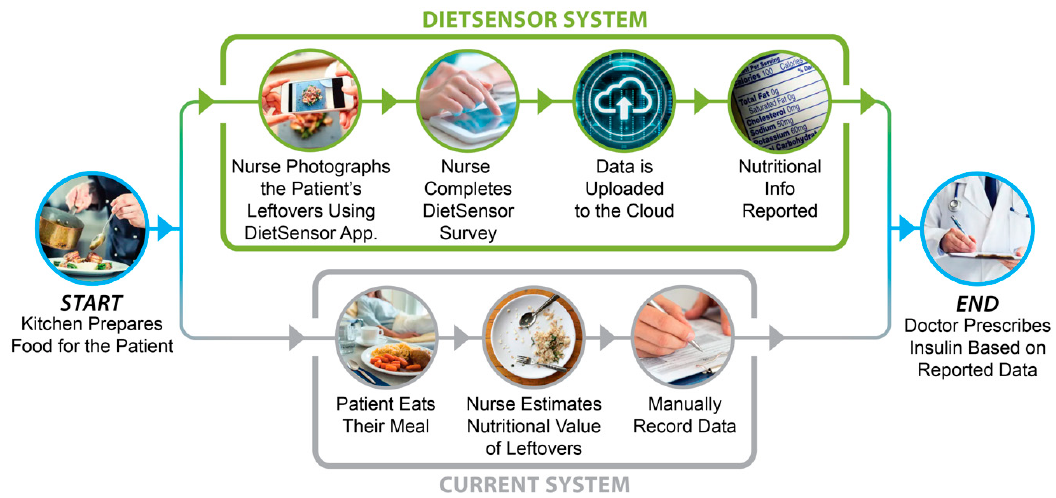
Figure 1. The DietSensor system replaces the existing estimation process by introducing an automated smartphone application to measure the leftover food volume on a patient's plate. The DietSensor system subtracts the reported nutritional data provided by the medical center's kitchen to measure the consumed amount and report to the physician.